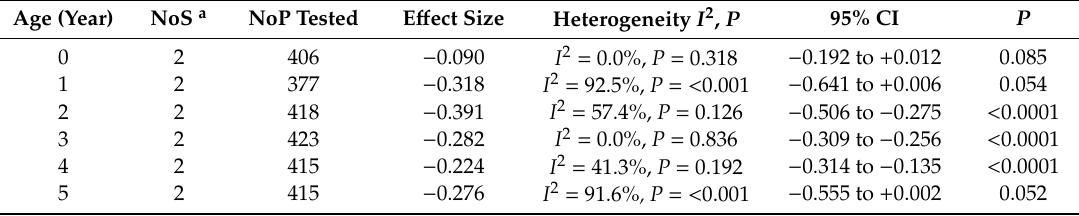
Table 6. Meta-analyses of weight-for-age z-scores in children with phenylketonuria.